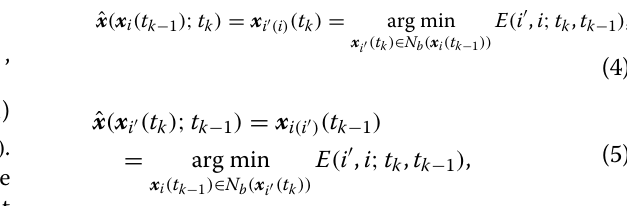
Our algorithm for hybrid-camera-based digital video stabilization consists of the following processes. In the steps of (1) feature point extraction and (2) feature